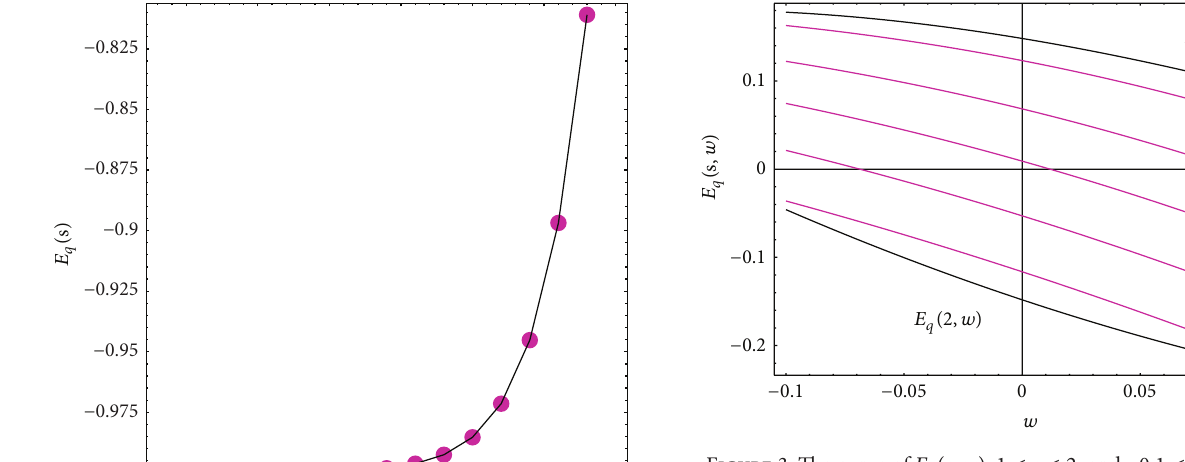
Figure 3: The curve of 𝐸 𝑞 (𝑠,𝑤) , 1 ≤ 𝑠 ≤ 2 , and −0.1 ≤ 𝑤 ≤ 0.1